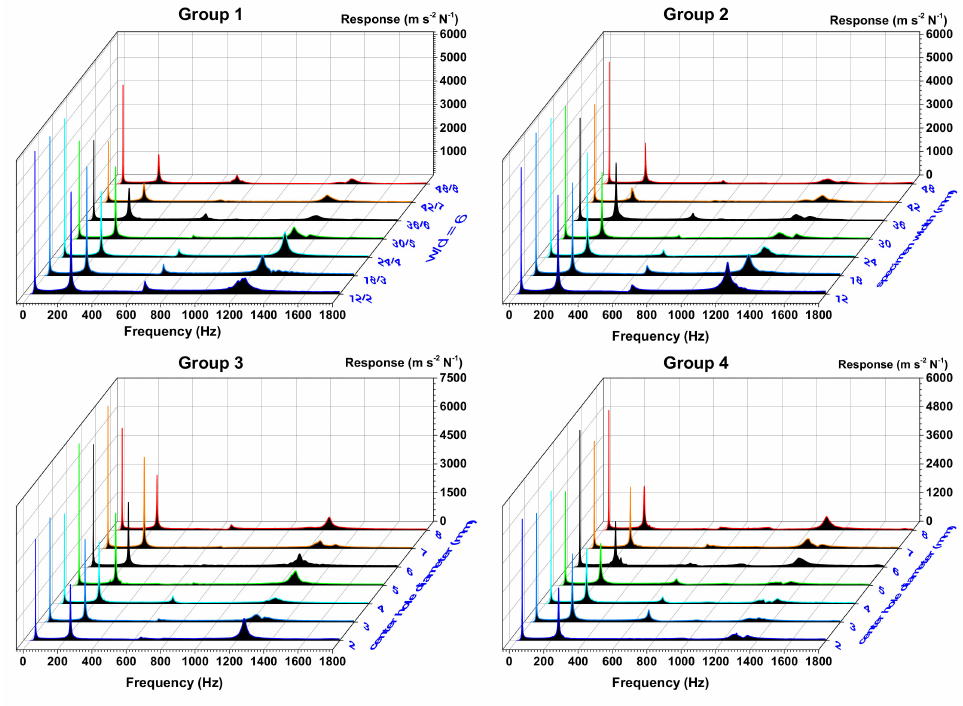
Figure 5. Auto spectrum analysis for all groups of